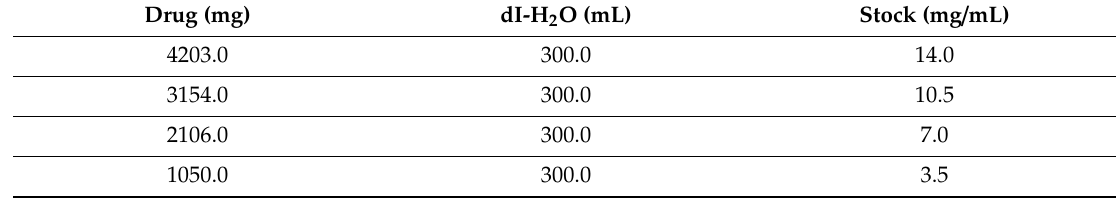
Table 1. Calculation of stock acetaminophen solution concentrations used in film formulations.